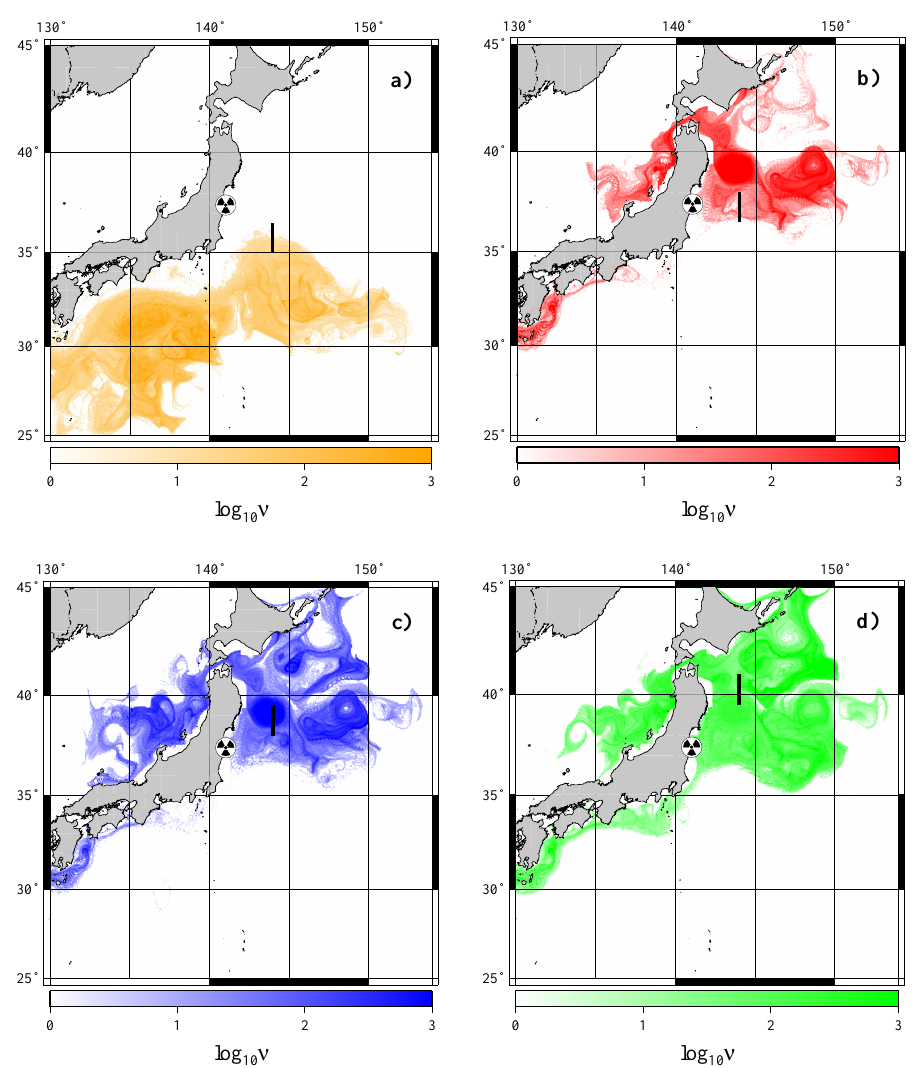
Fig. 5. Tracking maps for the markers placed on four material line segments along the transect where seawater samples have been collected on 26–29 July 2011 (Kaeriyama et al., 2013). The maps are colored as the corresponding segments in Fig. 2d and show where markers were walking from 11 March to 10 April 2011. Markers were initially placed along the 144 ◦ E meridian at the following segments: (a) 35 ◦ – 36 ◦ 30 0 N, (b) 36 ◦ 30 0 –38 ◦ N, (c) 38 ◦ –39 ◦ 30 0 N and (d) 39 ◦ 30 0 –41 ◦